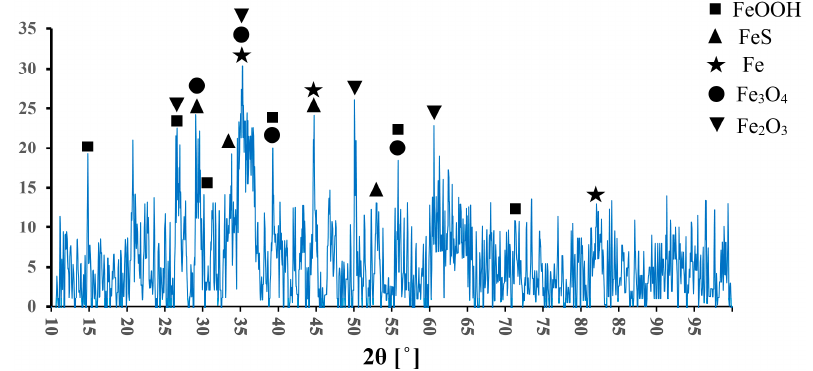
Figure 8. An X-ray diffraction analysis of the surface of the pipe.